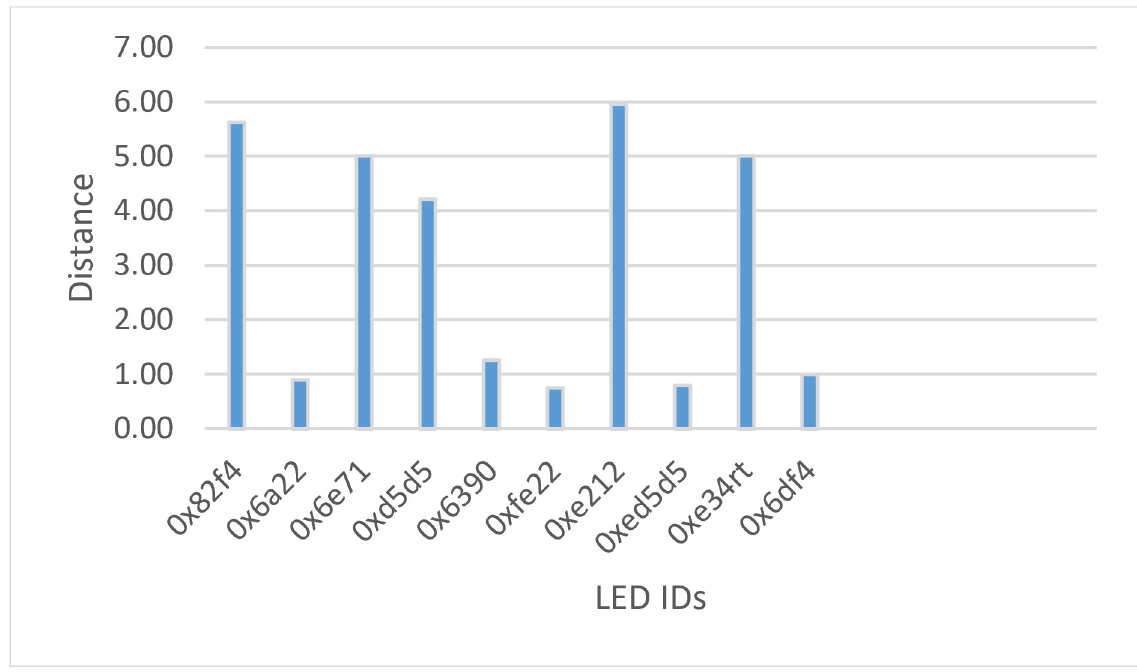
Fig 9. The LED IDs and the distance between mobile application and